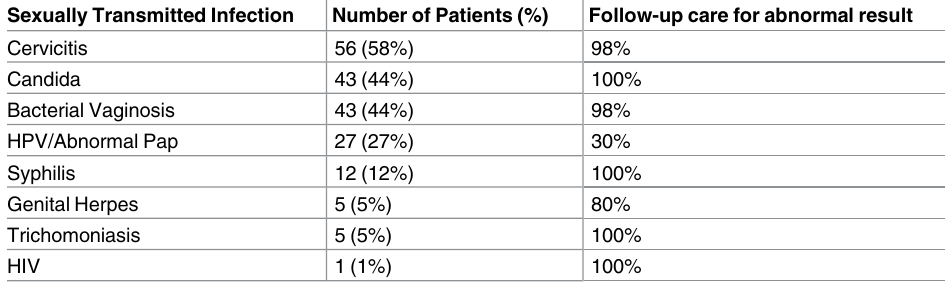
Table 2. Patient-reported prevalenceand follow-up for